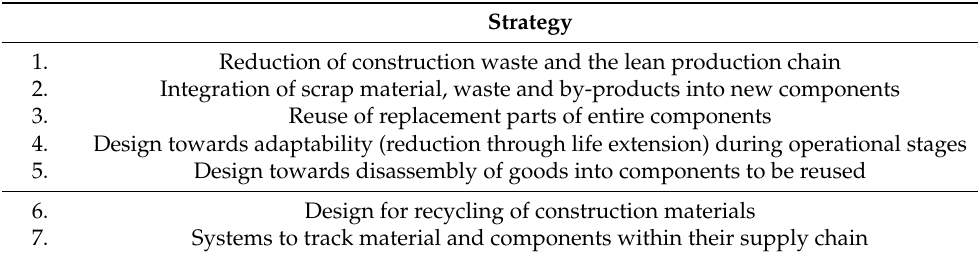
Table 1. Seven strategies found by Minunno et al. [36] that were implemented in the L3 case